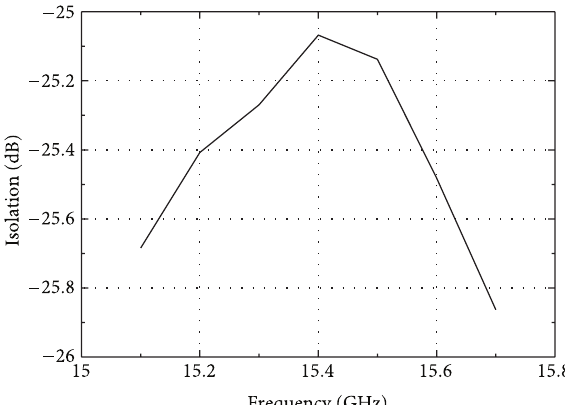
Figure 6: The isolation of the dual-polarized microstrip antenna array.